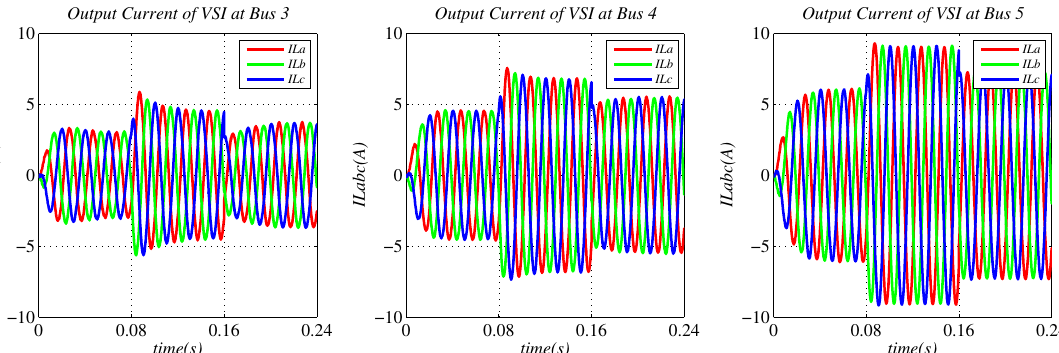
Figure 22. Output currents of the VSI at Buses 3, 4, and 5 in the abc reference frame (six-bus microgrid).